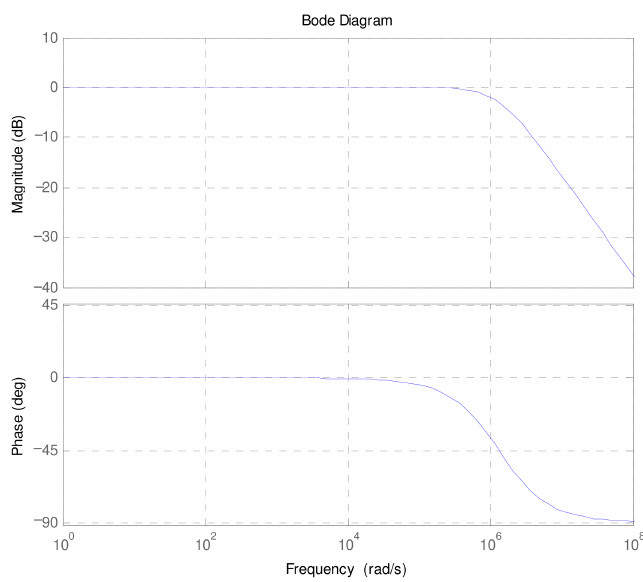
Figure 9. G c ( s ) frequency response curve.